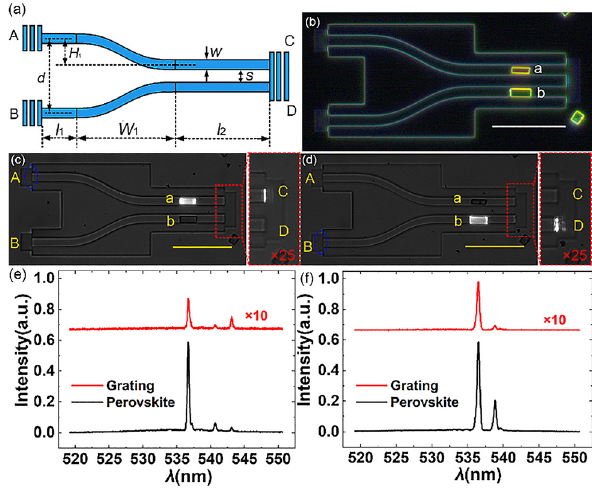
Figure 5: Selective pumping on-chip microlasers. (a) Schematic and structural parameters of two adjacent PMMA waveguides. (b) Dark-field optical image of a fabricated structure including two identical PMMA waveguides and two perovskite microplates.Thescalebaris20 μ m.Opticalimagesofthefabricated structure when the pump beam is focused on the grating A (c) and grating B (d). The scale bar is 20 μ m. The blue dashed ellipses indicate the pump spot. Inset is the zoomed-in image of the decoupling grating. Besides, the exposure time of the inset in right panel is 25 times longer than that of the optical image in left panel. (e) Measured emission spectra at the perovskite microplate a and the grating C . (f) Measured emission spectra from the perovskite microplate b and the grating D